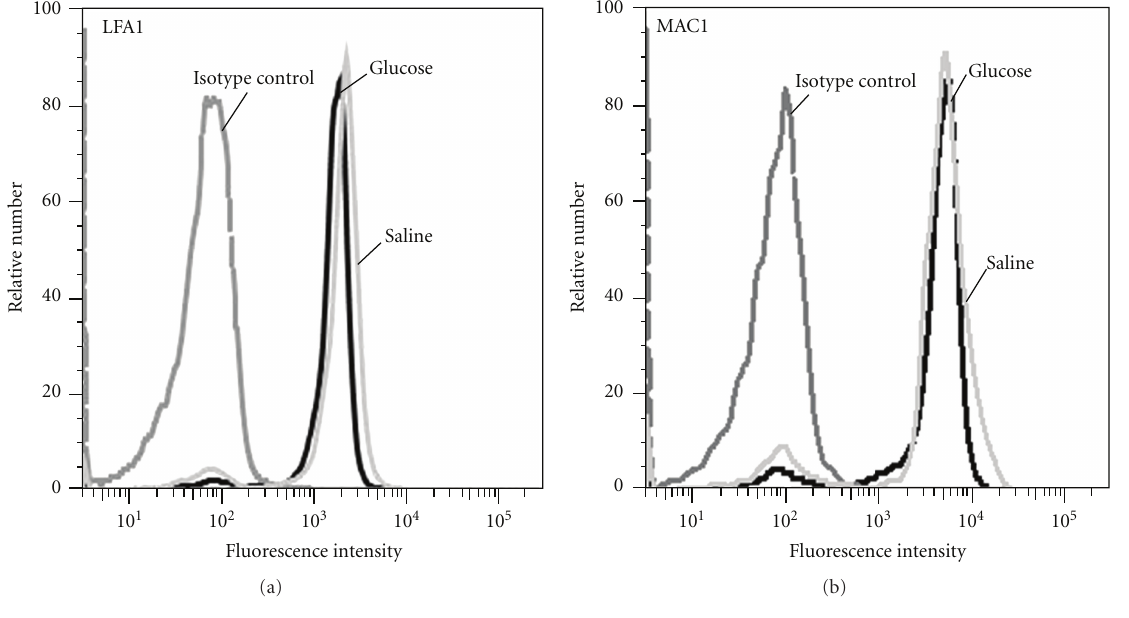
Figure 3: Glucose-dependent expression of LFA1 and MAC1 on neutrophils. Surface expression of LFA1 (a) and MAC1 (b) on bone marrow- derived neutrophils ( n = 3 mice) after stimulation with glucose (10mg per 10 6 leukocytes/mL, 1h at 37 ◦ C) was compared to unstimulated controls (b). Representative histograms are shown from 3 separate